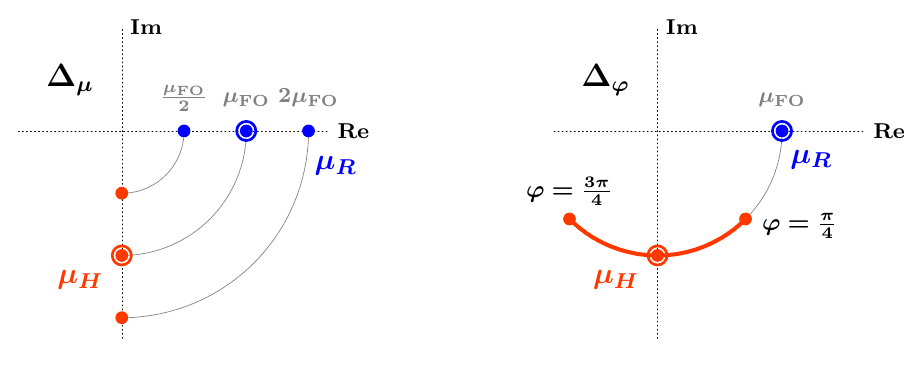
Figure 1 . Illustration of the scale variations used to estimate the perturbative uncertainties. Left: the overall variations of (cid:22) FO , which determines (cid:1) (cid:22) (in conjunction with the variation of (cid:20) F , which is not shown). Right: the phase variation for (cid:22) H for (cid:12)xed (cid:22) FO , which determines the resummation uncertainty (cid:1) ’